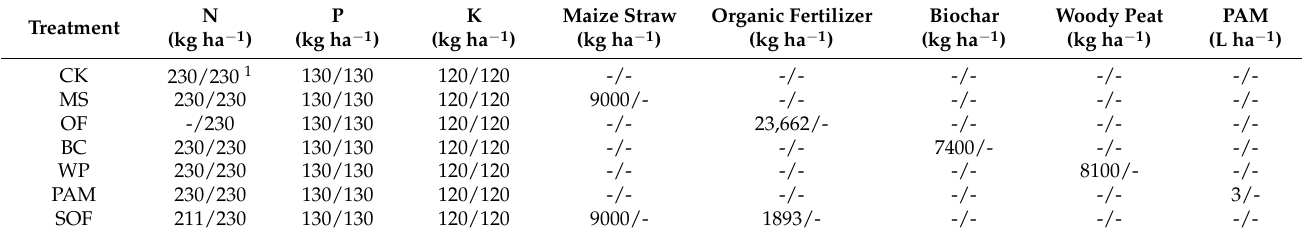
Table 2. Annual amounts used in the experimental